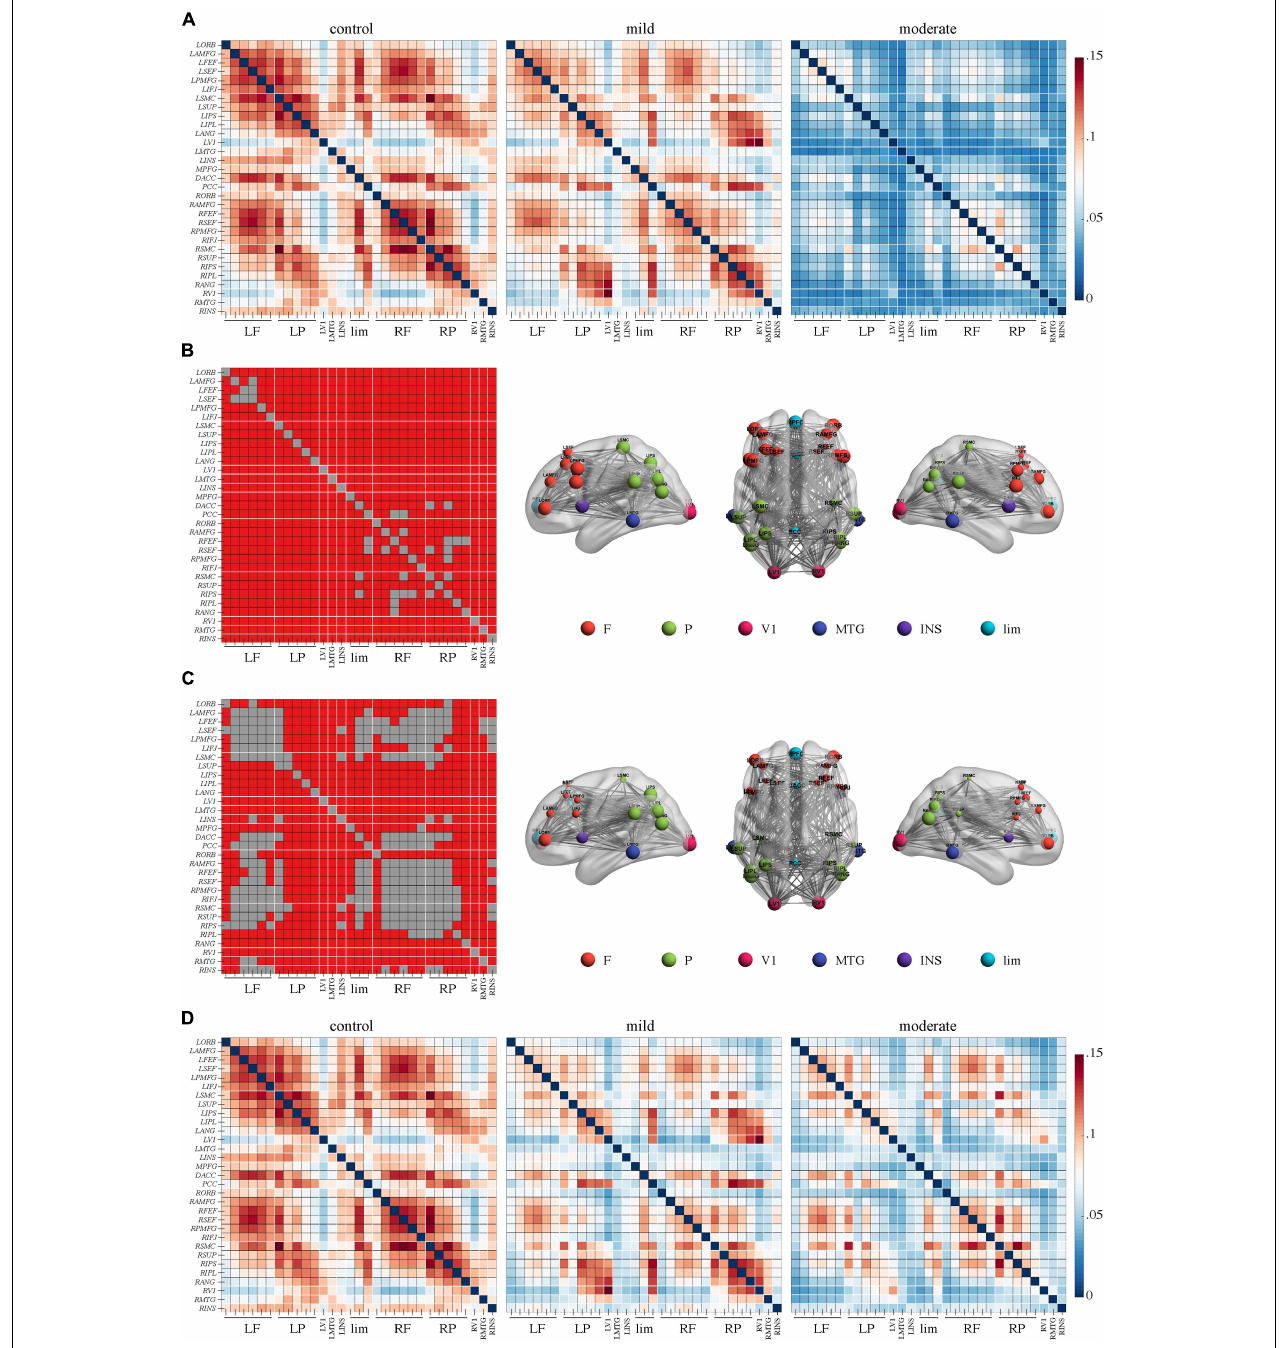
FIGURE 3 | Weaker connectivity in the beta frequency band in Alzheimer’s disease patients with moderate cognitive impairment before repetitive transcranial magnetic stimulation (rTMS). (A) Power envelope connectivity matrices of the control, mild, and moderate groups pre-rTMS. (B) The network-based statistics results of control group > moderate group pre-rTMS. Connectivity difference matrix (left panel) and its three-dimensional visualization (right panel) are shown. (C) The network-based statistics results of mild group > moderate group pre-rTMS. (D) Power envelope connectivity matrices of the control, mild, and moderate groups pre-rTMS. In (B,C) , the connectivity difference matrix (left panel) and its three-dimensional visualization (right panel) are shown. The three-dimensional visualization shows the left, up, and right views of the brain. The meaning of the red squares, size of node, and all abbreviations are the same as in Figure 1 .